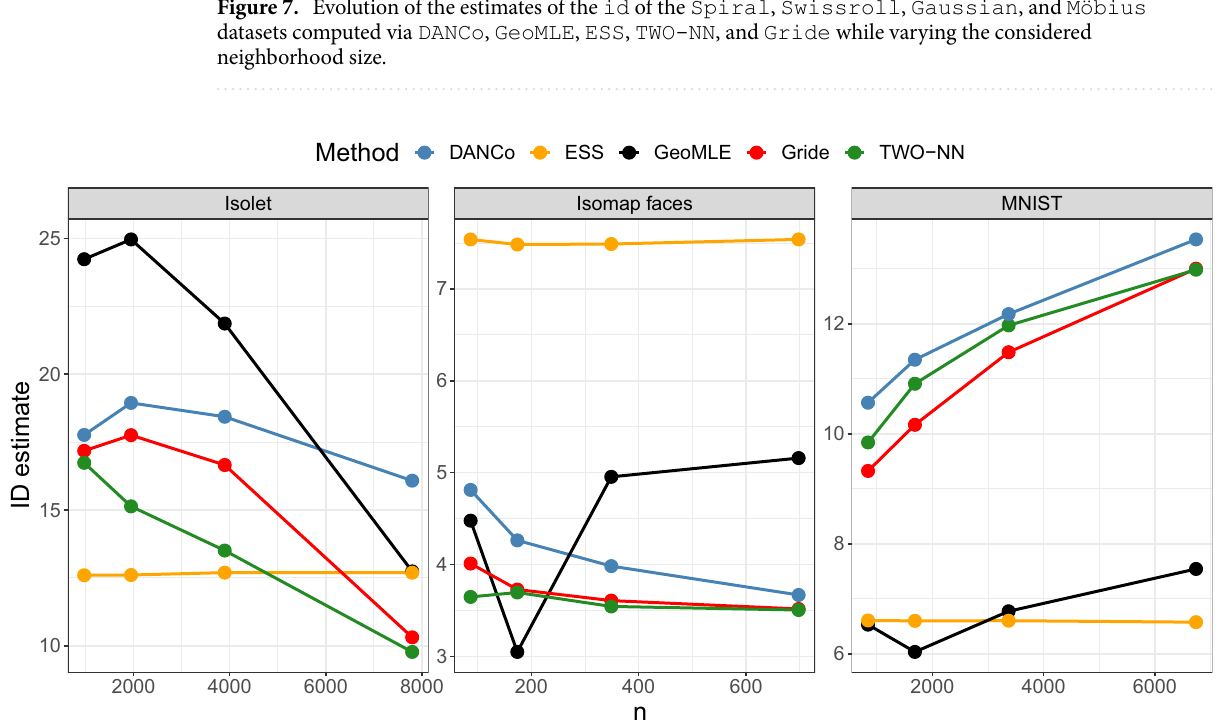
Figure 8. Evolution of the estimates of the id of the datasets Isolet , Isomap faces , and MNIST (digit 1) obtained with DANCo , GeoMLE , ESS , TWO-NN , and Gride varying the considered sample